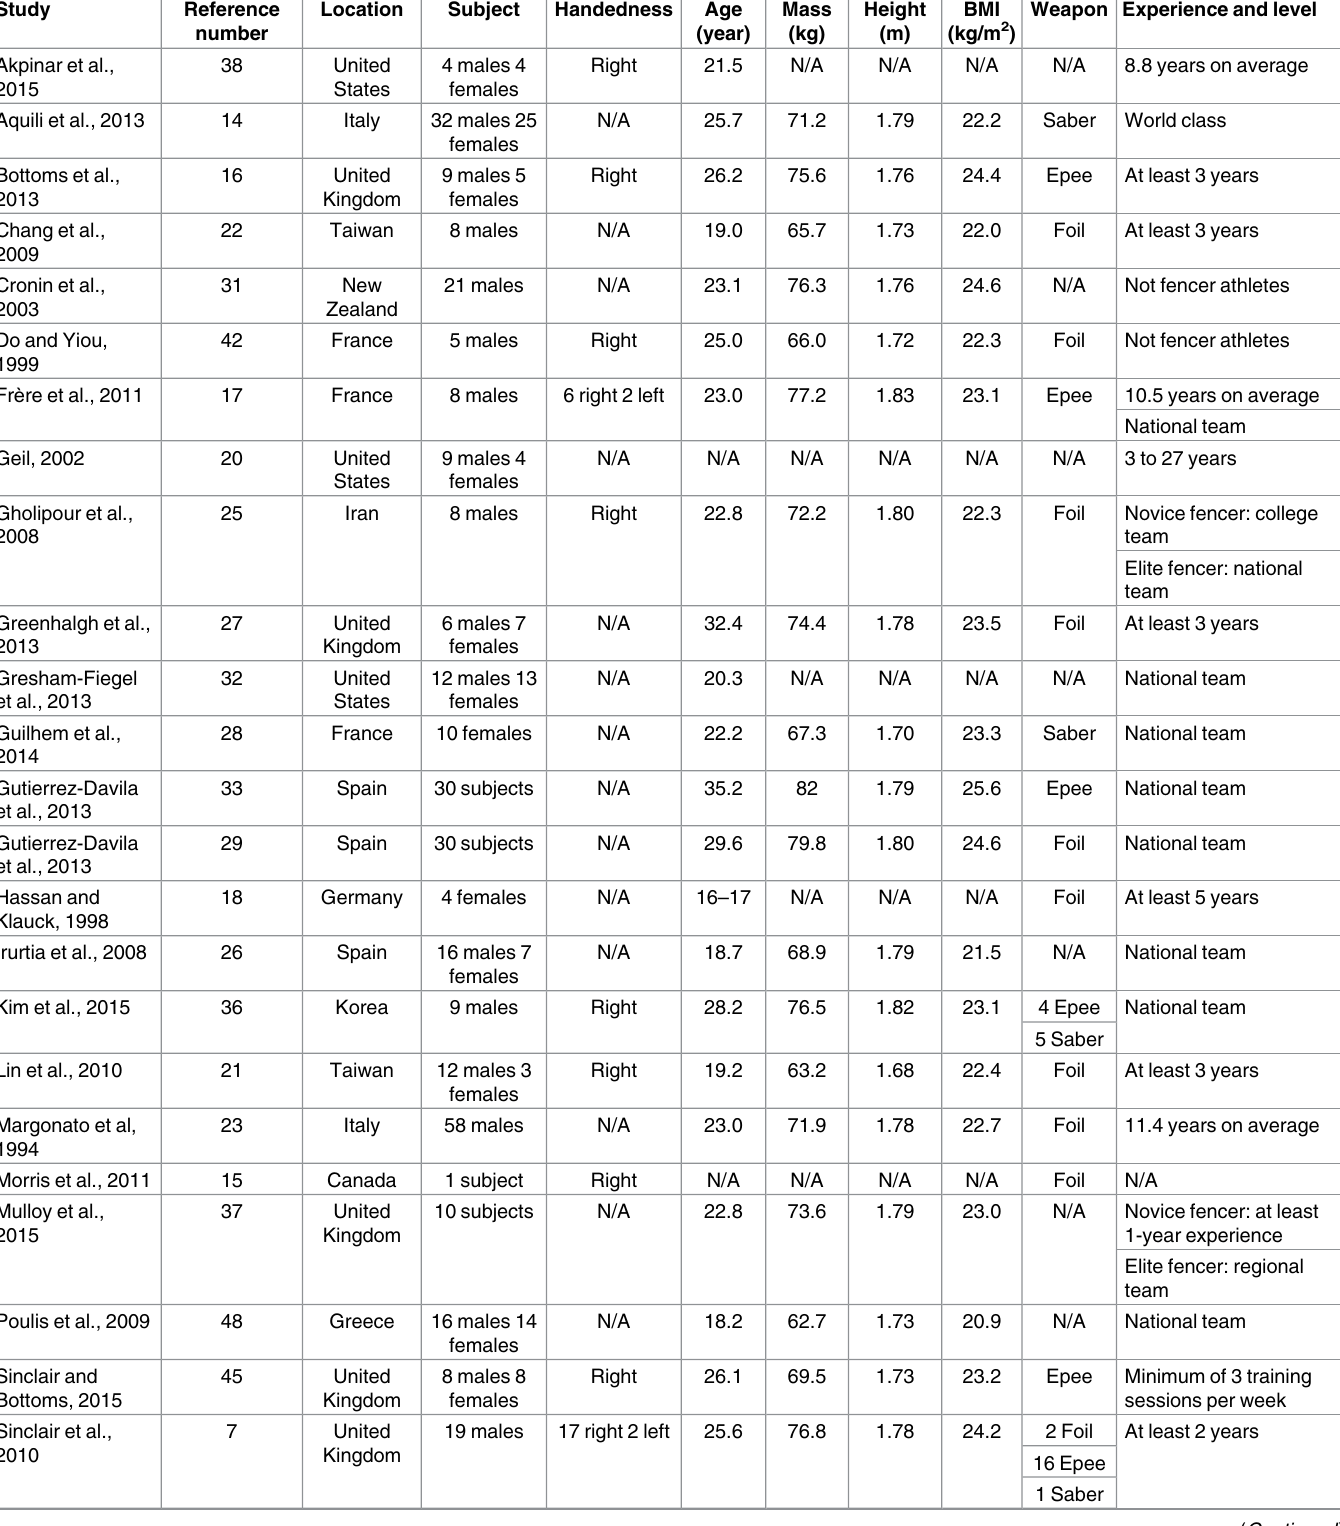
Table 1. Basic characteristics of the participants in studies included in our analysis.